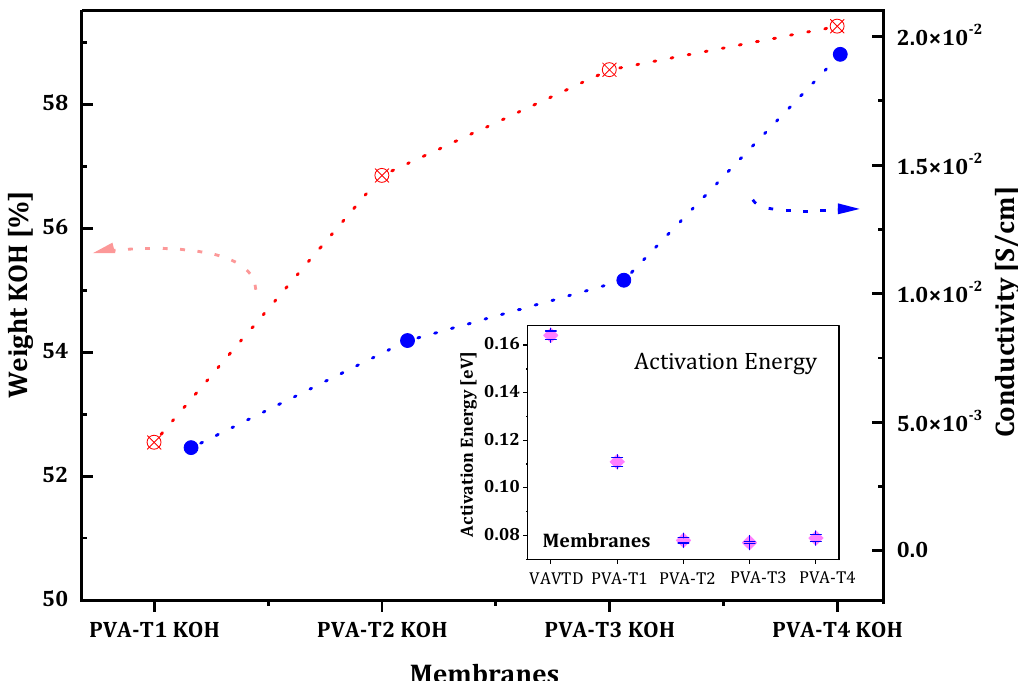
Figure 7. Ionic conductivity of PVA-based electrolytes at different temperatures. From the slope of the linear fitting, the Activation Energy (Ea) values for the GPEs studied can be calculated, which are shown in the inset of Figure 8. As can be seen, Ea values are higher for GPEs with a low amount of VAVTD, but this reaches a constant value of ~0.033 eV for the membrane with a higher VAVTD quantity.